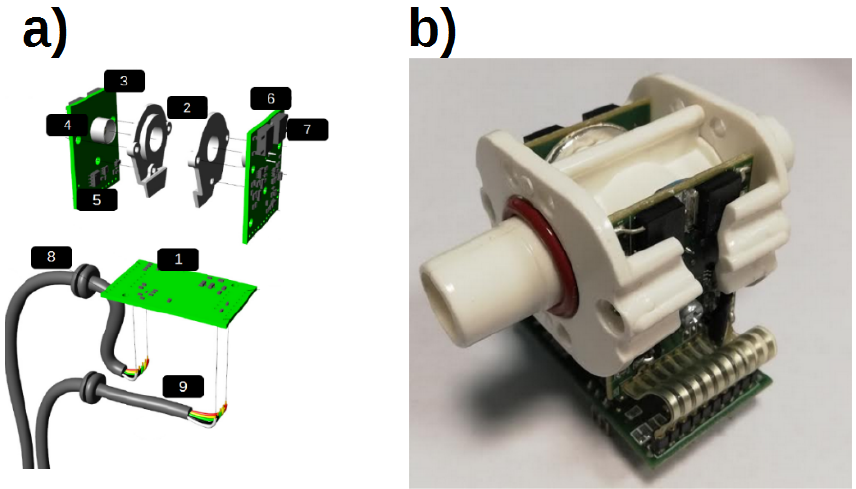
Figure 4. Schematic representation of the sensor.